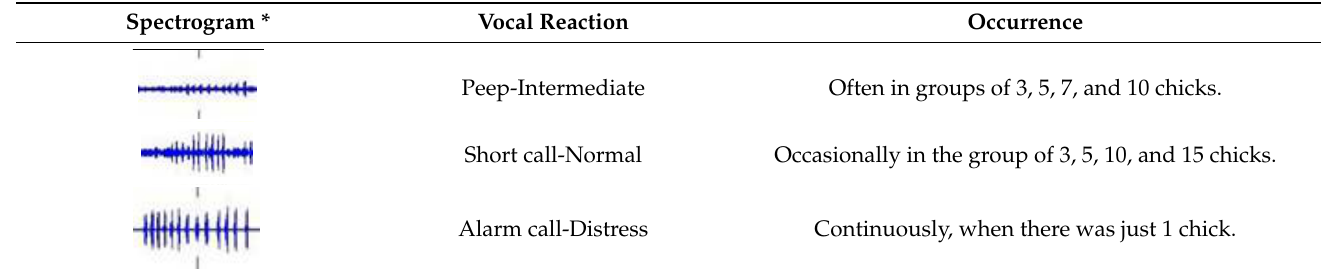
* A spectrogram is an image of the signal spectrum frequencies as it varies with time.